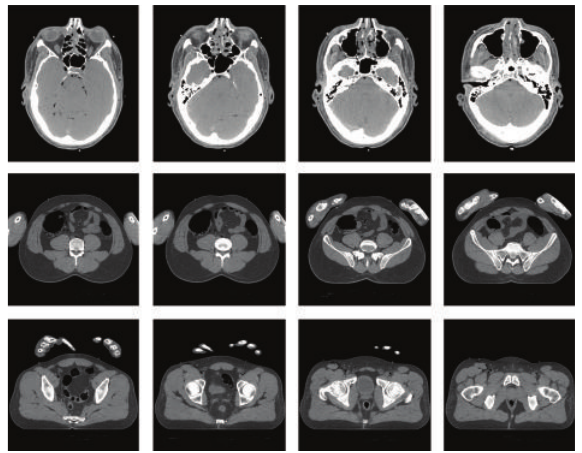
Figure 3: Examples of clinical images used in the experiments. Upper row: axial head slices displayed in the range (HU window) of [−170,250] ), middle row: abdomen images, lower row: thigh images. The two lower rows are displayed in the HU window [−220, 350] . Head images are slightly enlarged relative to other regions for better